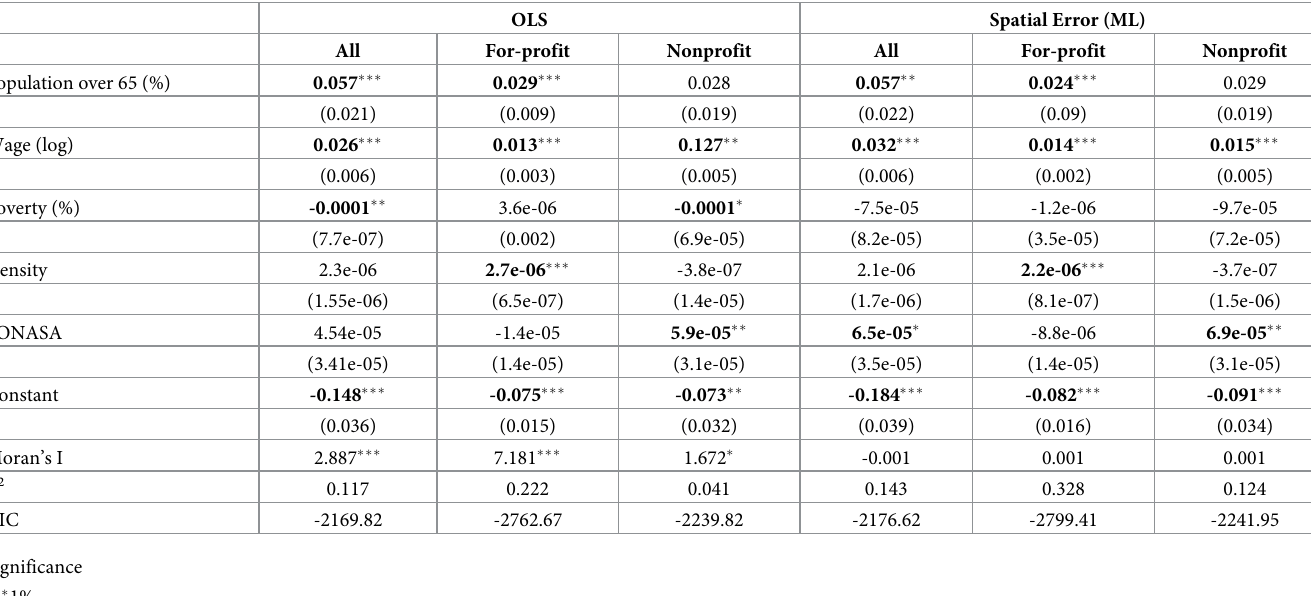
Table 3. Determinants of coverage: OLS and spatial error estimations (N =